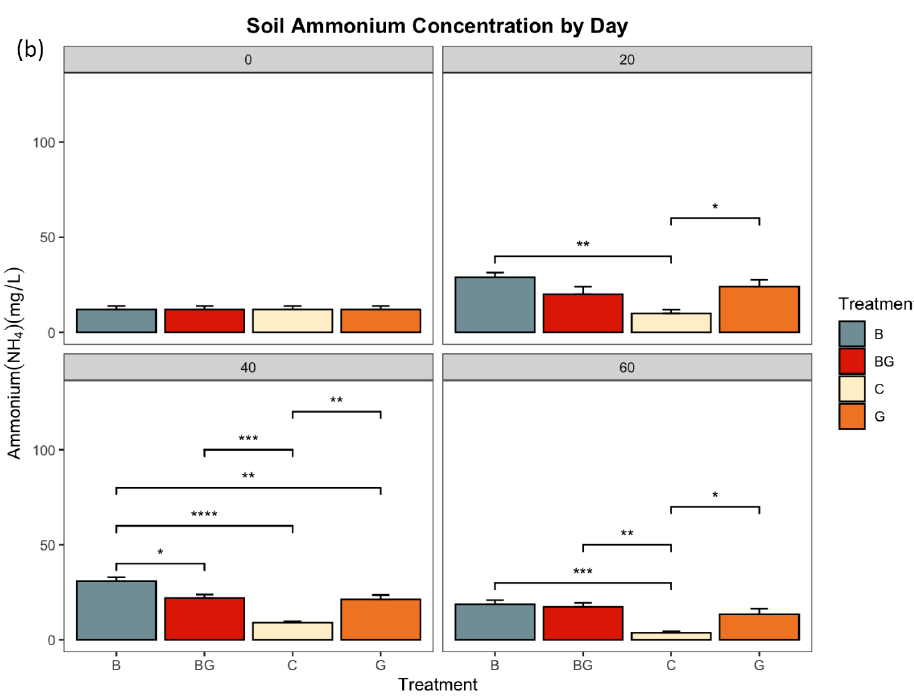
Figure 4. Nitrate and ammonium concentrations across time. Nitrate concentration ( a ) and ammonium concentration ( b ) in soil were determined by a colorimetric assay at days 0, 20, 40, and 60. Statistical analysis was performed using ANOVA (one way). Results are shown as the mean ± SEM, Significance level: 0.05 (*), 0.01 (**), 0.001 (***), <0.001 (****).